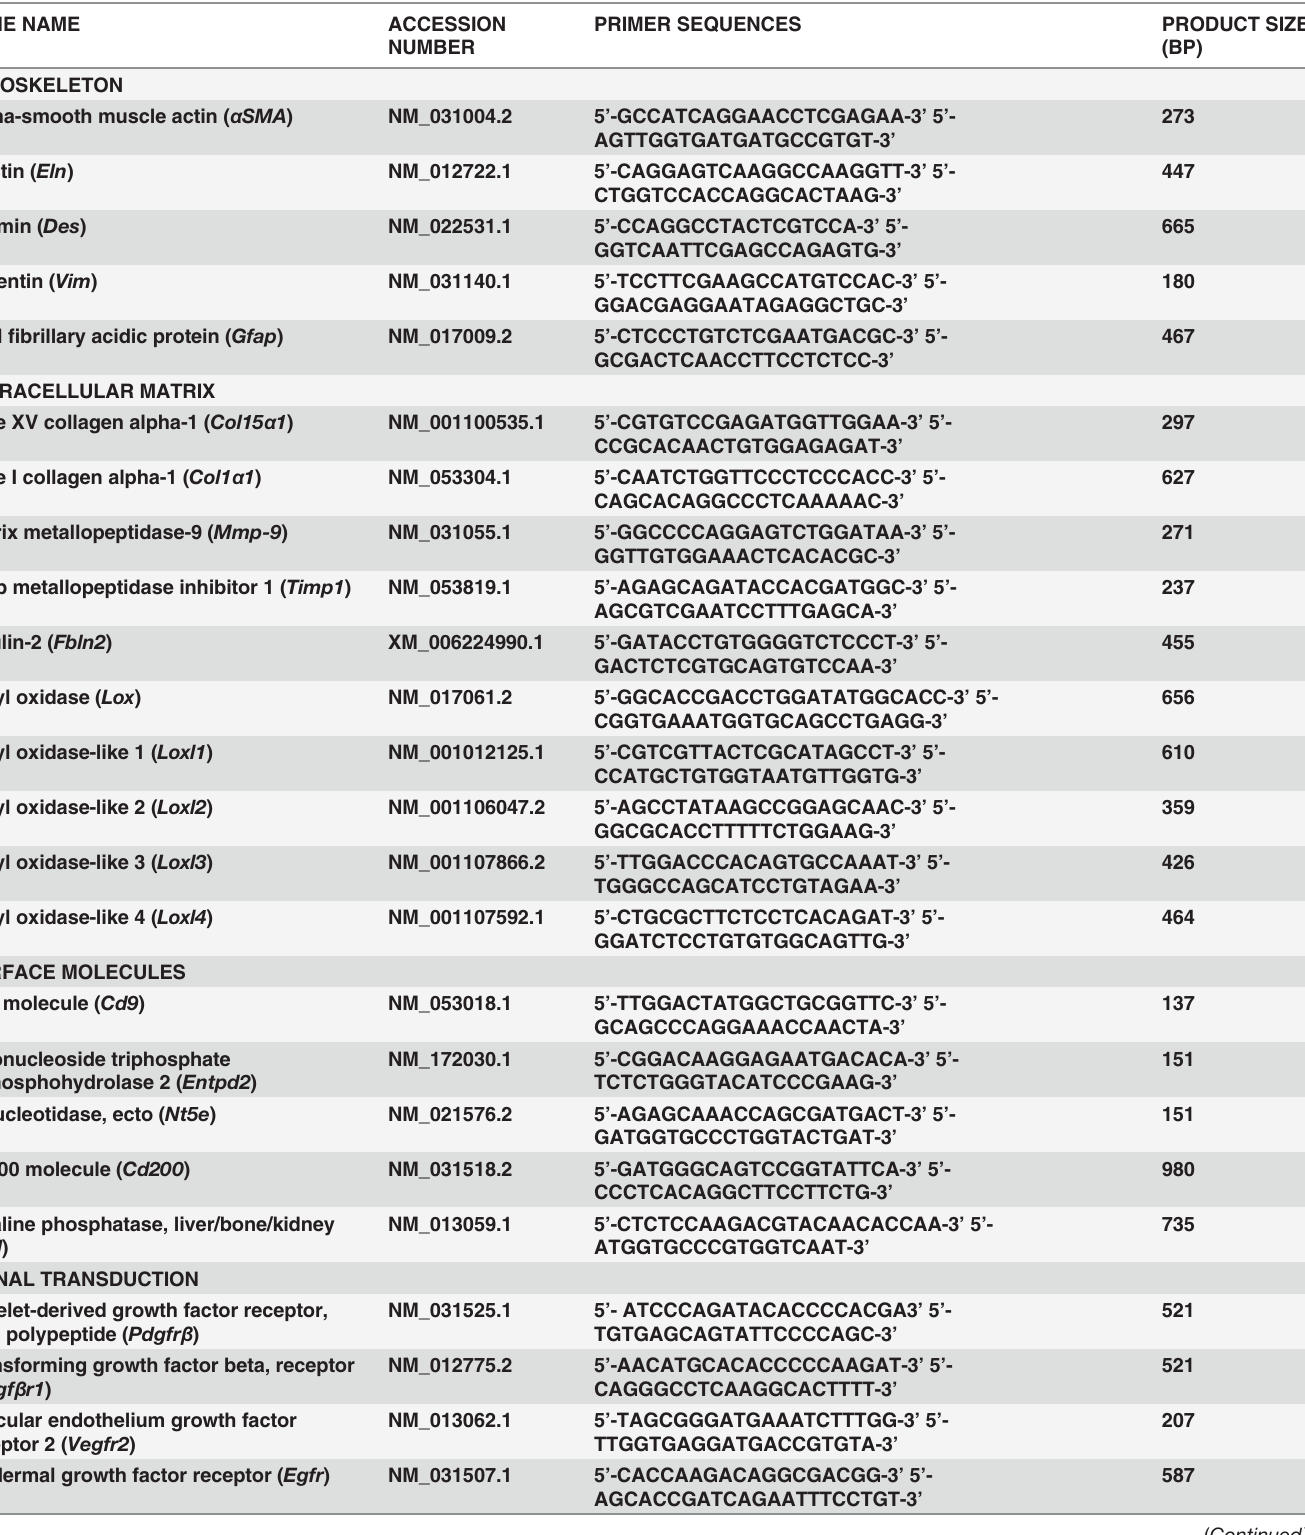
Table 1. Sequences of primer sets used for gene expression analysis by